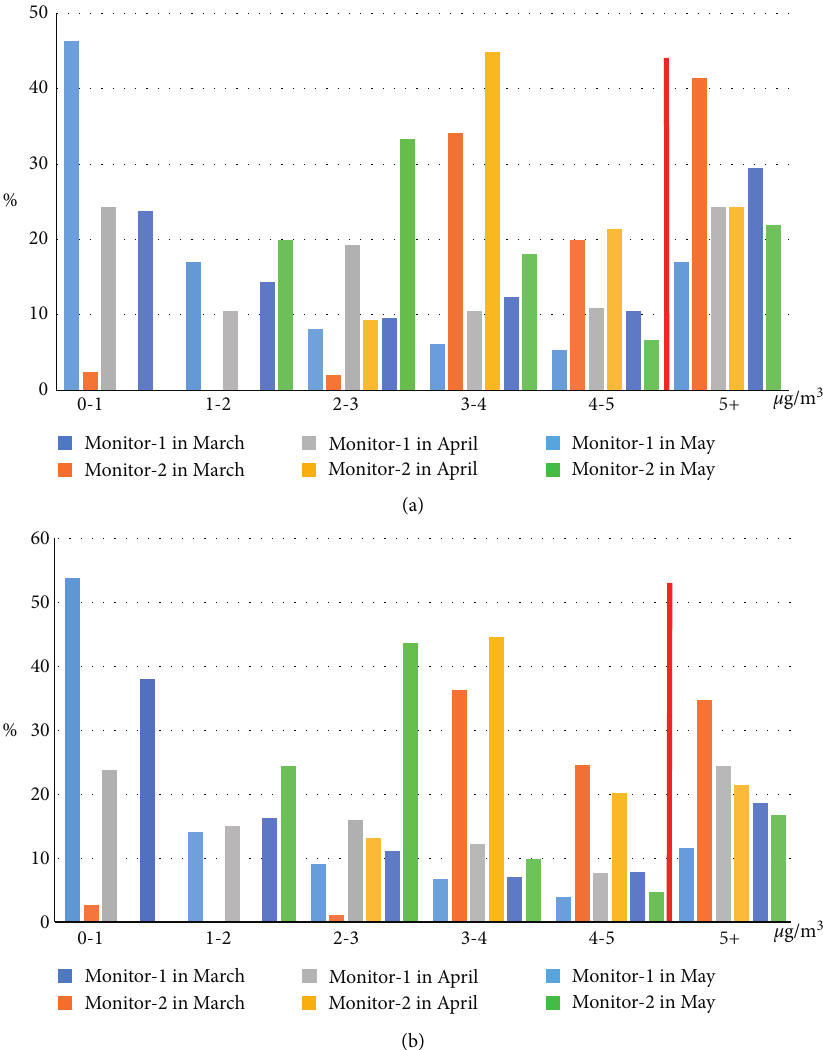
Figure 5: Percentage distribution of average SO 2 concentrations per hour for (a) periods of ship movement in or out the dock versus (b) periods of no ship movement in or out the